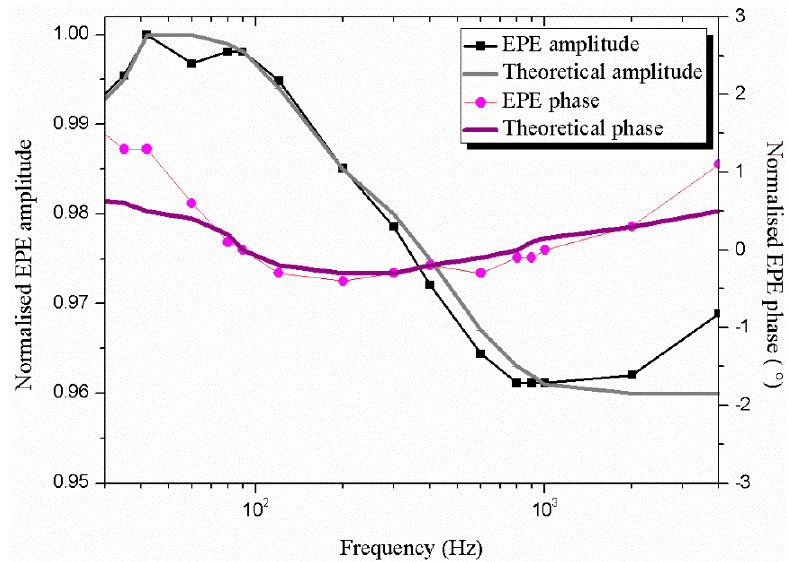
Figure 9. Experimental (dots) and theoretical (line) normalized amplitude and phase of the electropyroelectric signal according to the frequency modulation for MoO 3 sample . Table 6. Thermal parameters of Fe-Co doped MoO 3 .